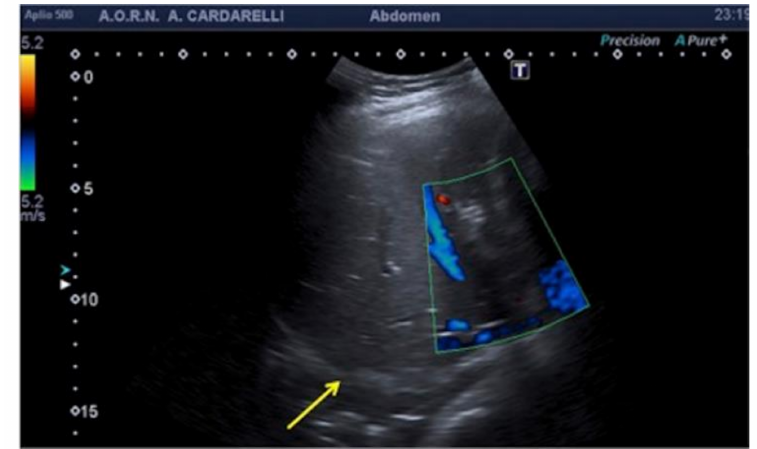
Figure 7. Longitudinal US image of the liver shows that the interface between the liver and the diaphragm (arrow) is discontinuous and focally displaced. This appearance may be explained by areas of focal fat within the liver.